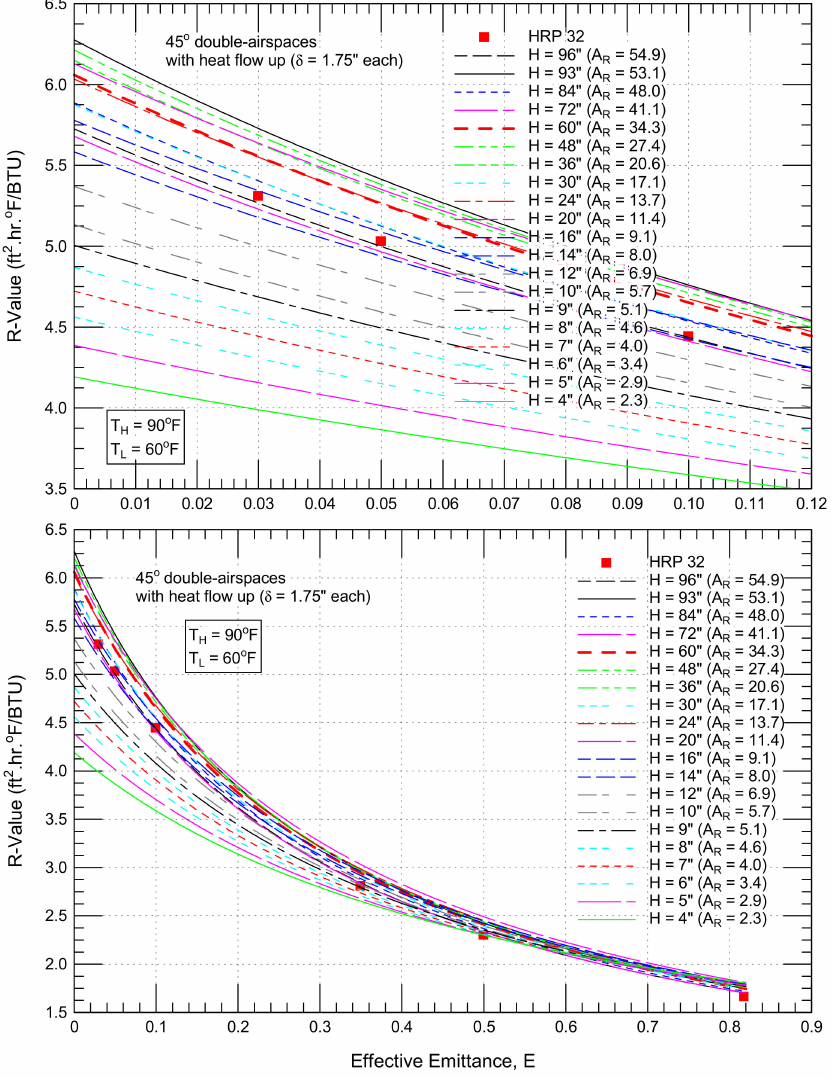
Figure 19. Comparisons of R values of HRP 32 [4] with present model predictions of various A R for sloped double airspaces subjected to an upward heat flow ( θ = 45 ◦ , total δ = 3.5 inches, T H = 90 ◦ F, T L = 60 ◦